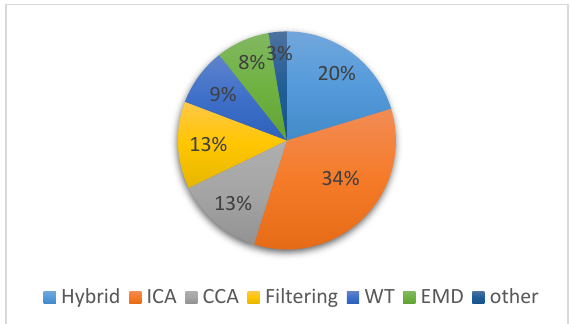
Figure 1. Percentage of the number of references published during the past three years.